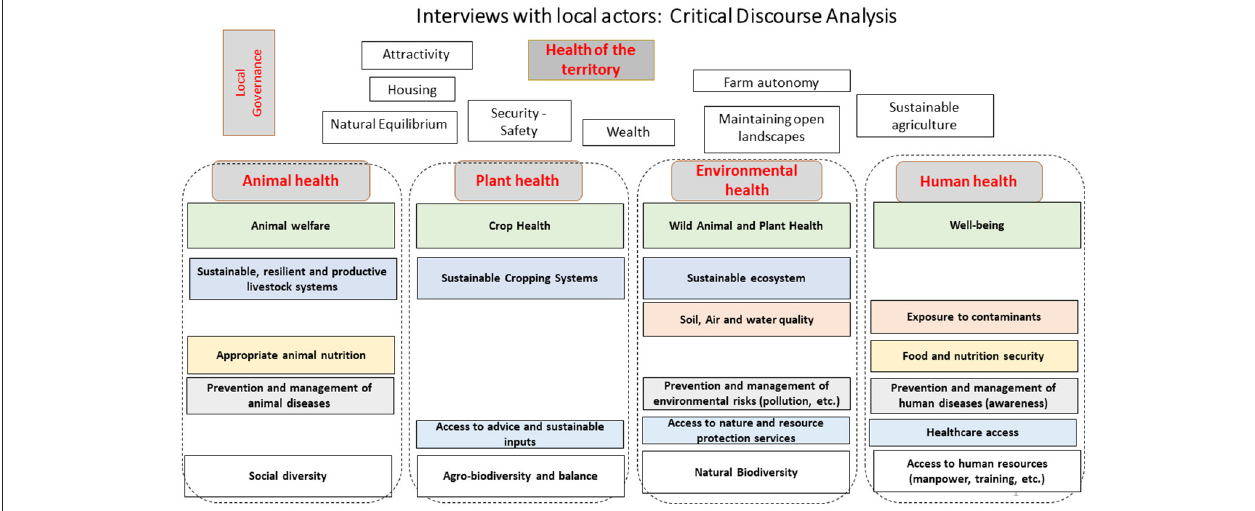
FIGURE 4 | Attributes of the Health of the Territory, following a critical analysis of local stakeholders’ discourses using a framework derived from SESH framework ( Figure 1 ) to account for the specific context of agroecological transitions in Southern France.